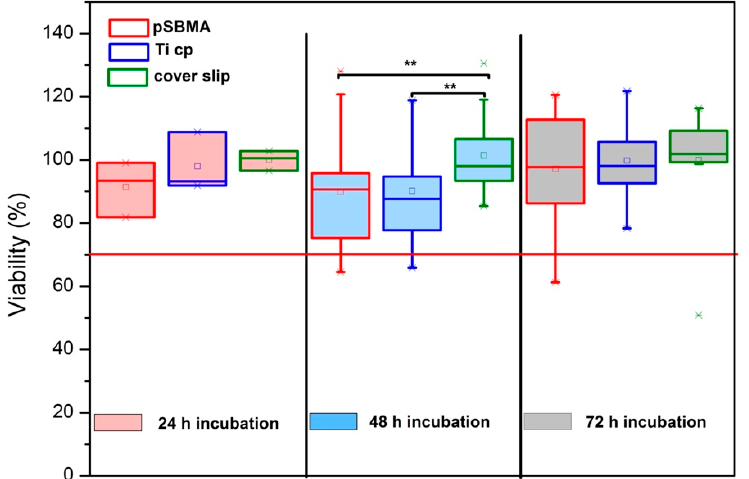
Figure 5. Viability results of hgF-facing inserts containing pSBMA-coated TiCP (pSBMA), bare TiCP (TiCP), and Thermanox cover slips for different incubation periods: 24 h (red), 48 h (blue), and 72 h (gray). A threshold of 70% for the cytotoxic potential of materials (ISO 10993-5:2009E) is indicated by the red line. One-way ANOVA testing was used to compare the viabilities obtained for the presence of different sample surfaces within each incubation period. ** denotes significantly different results obtained via a Tukey post-hoc test.